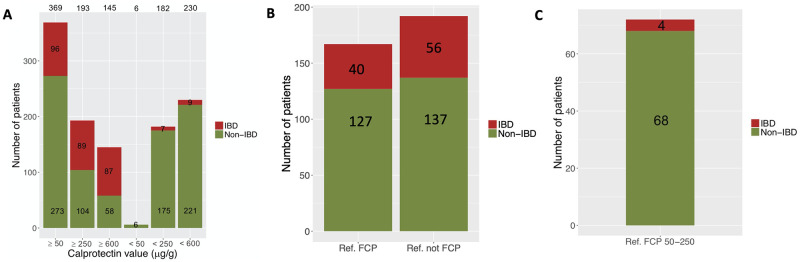
A Proportion of patients with newly diagnosed IBD (red) and without IBD (green) according to their FCP of </≥ 50 μg/g, </≥ 250 μg/g and </≥ 600 μg/g. The difference between IBD diagnoses in patients with FCP < and ≥ 250 μg/g as well as in those with FCP < and ≥ 600 μg/g is statistically significant (p < 0.05). B Proportion of patients with/without IBD who were referred due to and not due to their elevated FCP (Ref. FCP and Ref. not FCP, respectively). C Proportion of patients with/without IBD and referred due to their FCP of 50–250 μg/g.